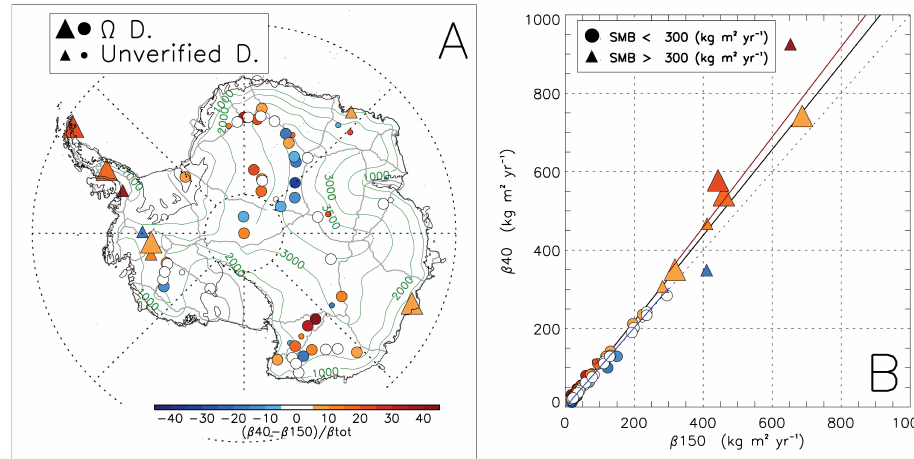
Fig. 3. (A) Geographical distribution of SMB temporal variability. Data were obtained from the ratios (expressed as percentages) of differ- ences in the SMB values between 1960–present ( β 40) and Tambora–1960s ( β 150) with respect to the SMB values of the entire ice core length ( β tot); sites with SMBs greater than 300kgm − 2 yr − 1 and lower than 300kgm − 2 yr − 1 are represented with triangles and filled cir- cles, respectively. Larger symbols indicate sites included in the verified ( (cid:127)) dataset. (B) Relationships in SMB temporal variability of the last two century. Data were obtained from the values for all sites in the datasets between the 1960s–present ( β 40) and Tambora–1960s ( β 150); filled colour represents ratios (expressed as percentages) of differences in the SMB values between 1960–present ( β 40) and Tambora– 1960s ( β 150) with respect to the SMB values of the entire ice core length ( β tot). Sites with SMBs greater than 300kgm − 2 yr − 1 and lower than 300kgm − 2 yr − 1 are represented with triangles and filled circles, respectively. Larger symbols indicate sites included in the verified ( (cid:127)) dataset. Linear relation between β 150 and β 40 values using the entire verified ( (cid:127)) dataset, only values greater than and lower than 300kgm − 2 yr − 1 are represented in black, red and blue lines,